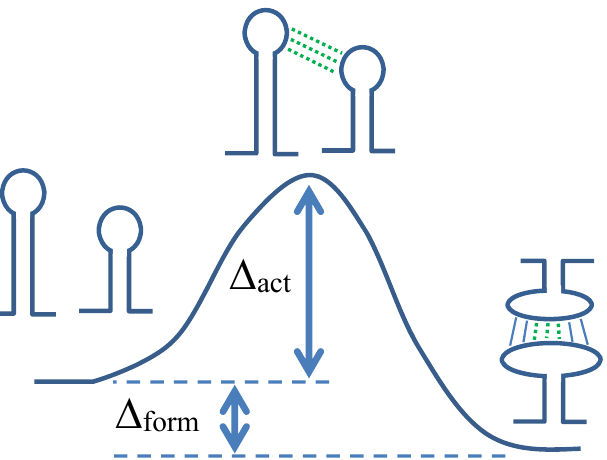
Figure 1. A schematic illustration of the hybridization process between two structured RNA strands. Two independently folded strands (shown on the left) are hybridized into the joint secondary structure (an RNA–RNA complex) shown on the right. Dotted lines are the base pairs of an interaction seed. Base pairs indicated by solid lines are intermolecular base pairs other than the base pairs of the interaction seed. ∆ form and ∆ act are the formation and activation free energy,